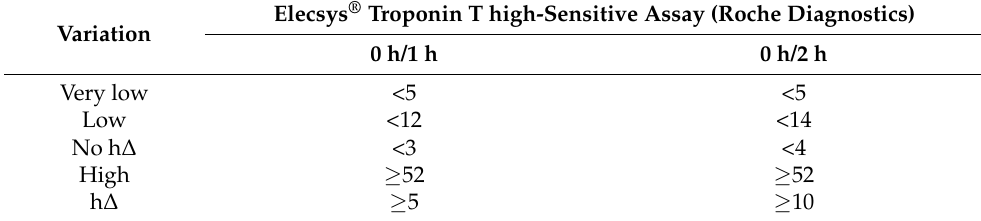
Table 3. Troponin T assay specific cut-off levels in the rule-in or rule-out 0 h/1 h and 0 h/2 h algorithms in NSTEMI diagnosis; values are expressed in ng/L; adapted from [7].